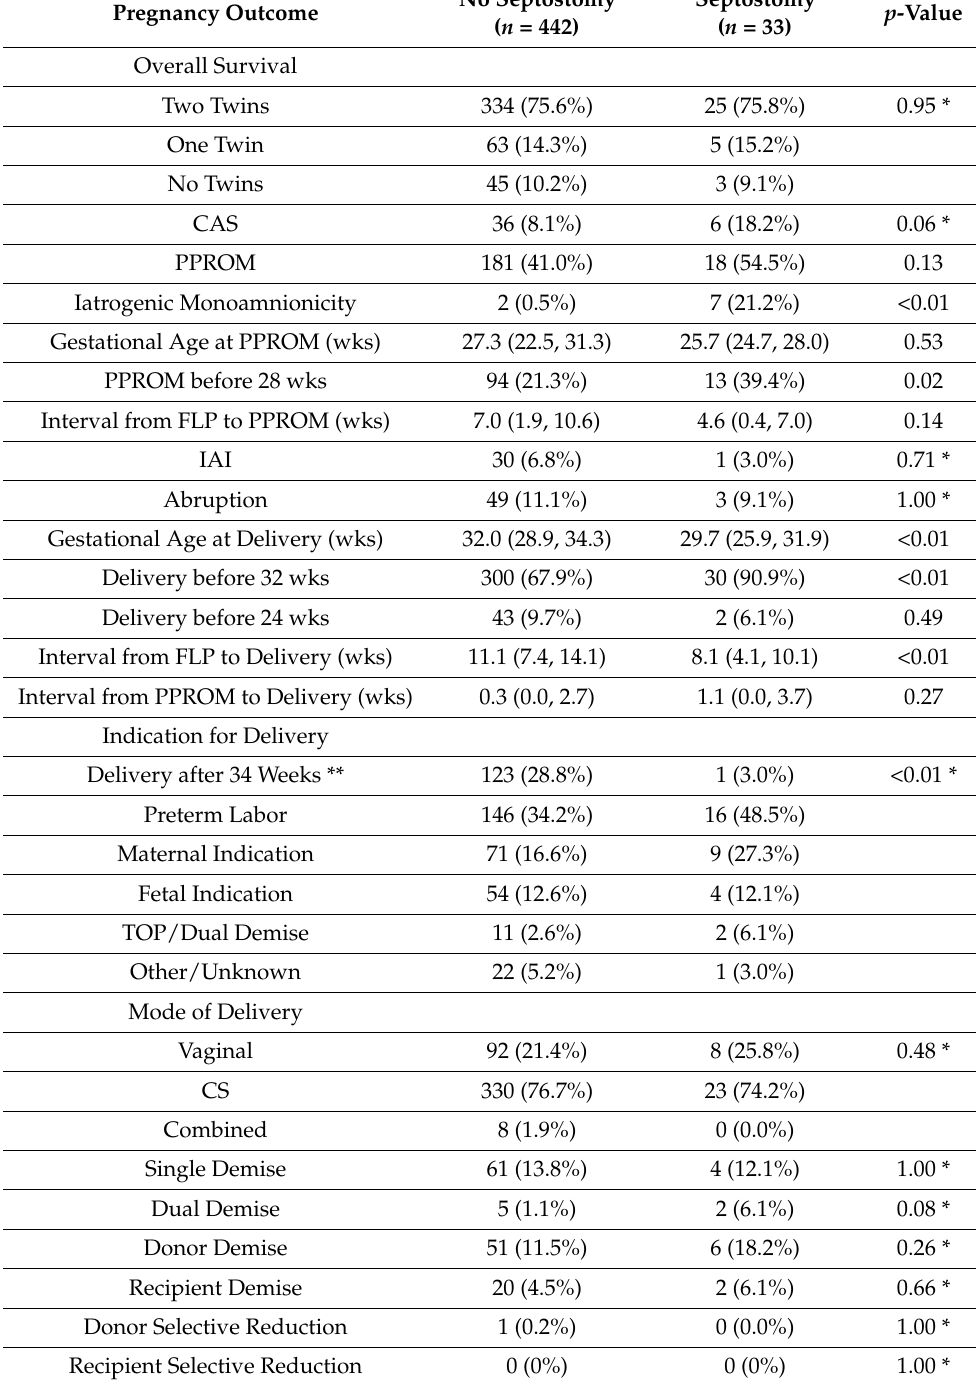
Table 3. Pregnancy outcomes following fetoscopic laser